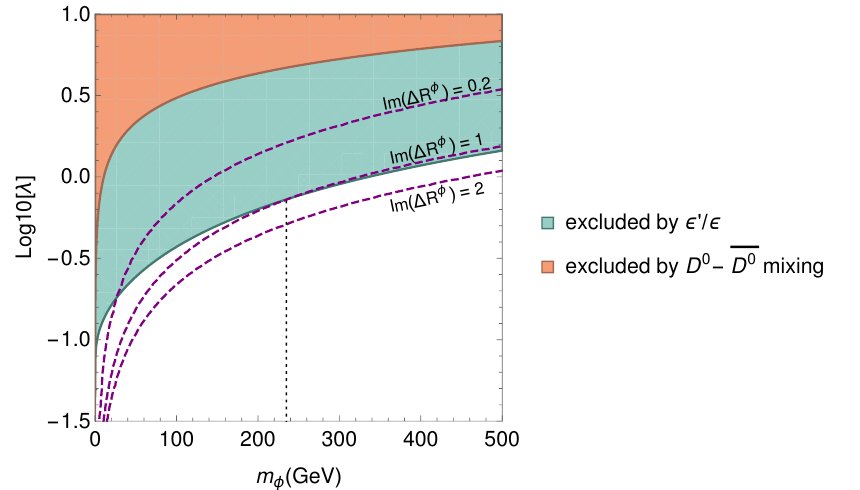
Figure 1 . Excluded regions in parameter space due to D 0 (cid:0) D 0 mixing and (cid:15) 0 =(cid:15) constraints. The dashed lines depict the curves for which (cid:1) A CP is explained for I m ((cid:1) R (cid:30) ) = 0 : 2 ; 1 ; 2. The dotted vertical line marks the intersection, at m (cid:30) ’ 235